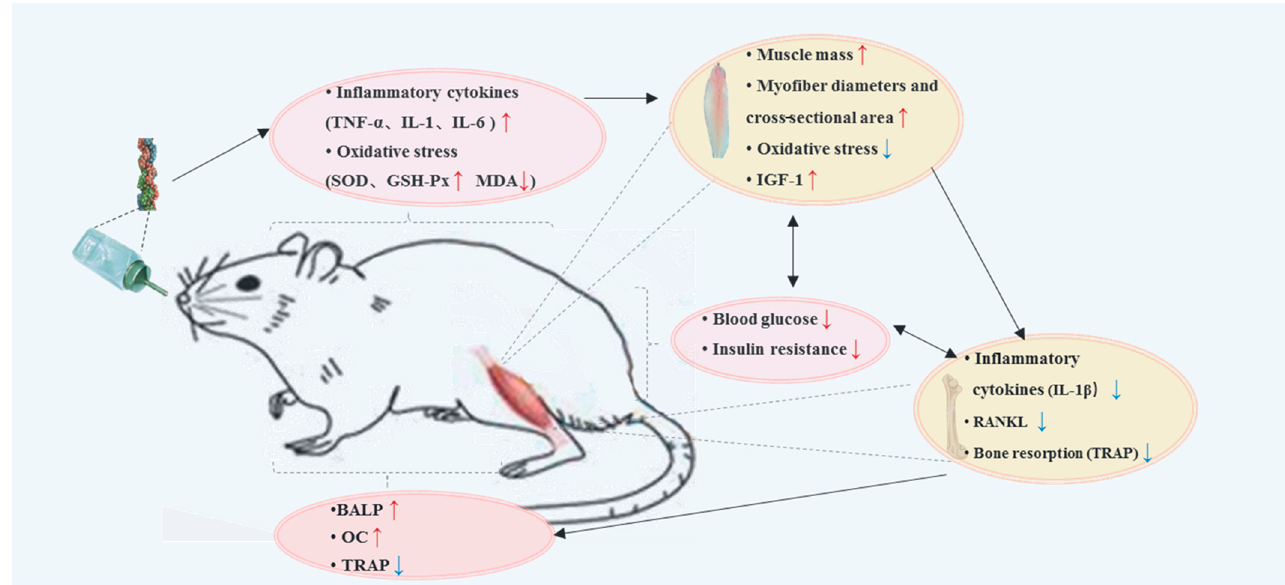
Figure 8. Graphical summation of the effect of UC II on impaired bone improvement and its likely mechanism.